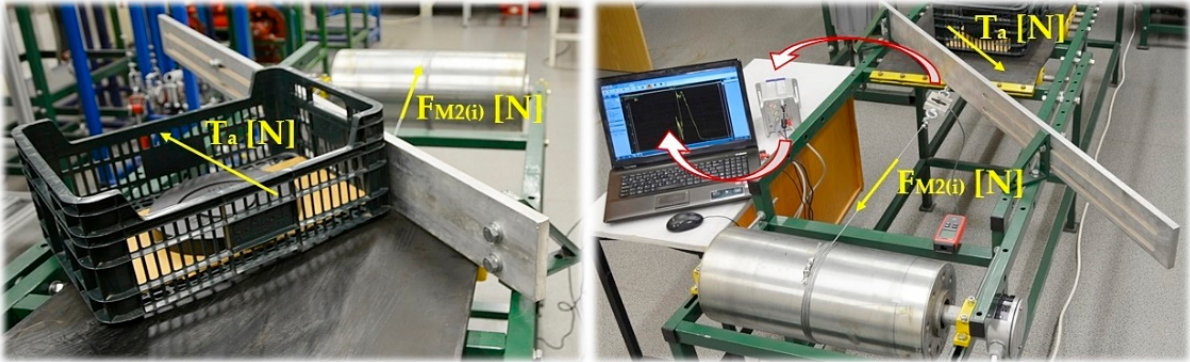
Figure 13. Tensile force F M2(i) [N] measurement carried on using a laboratory device.